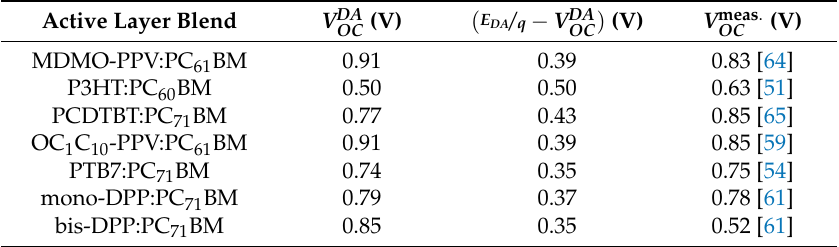
Table 4. The calculated values of open circuit voltage values listed in Tables 2 and 3, respectively, voltage offset )( excitation of both the donor and acceptor materials, and the corresponding measured open circuit voltage